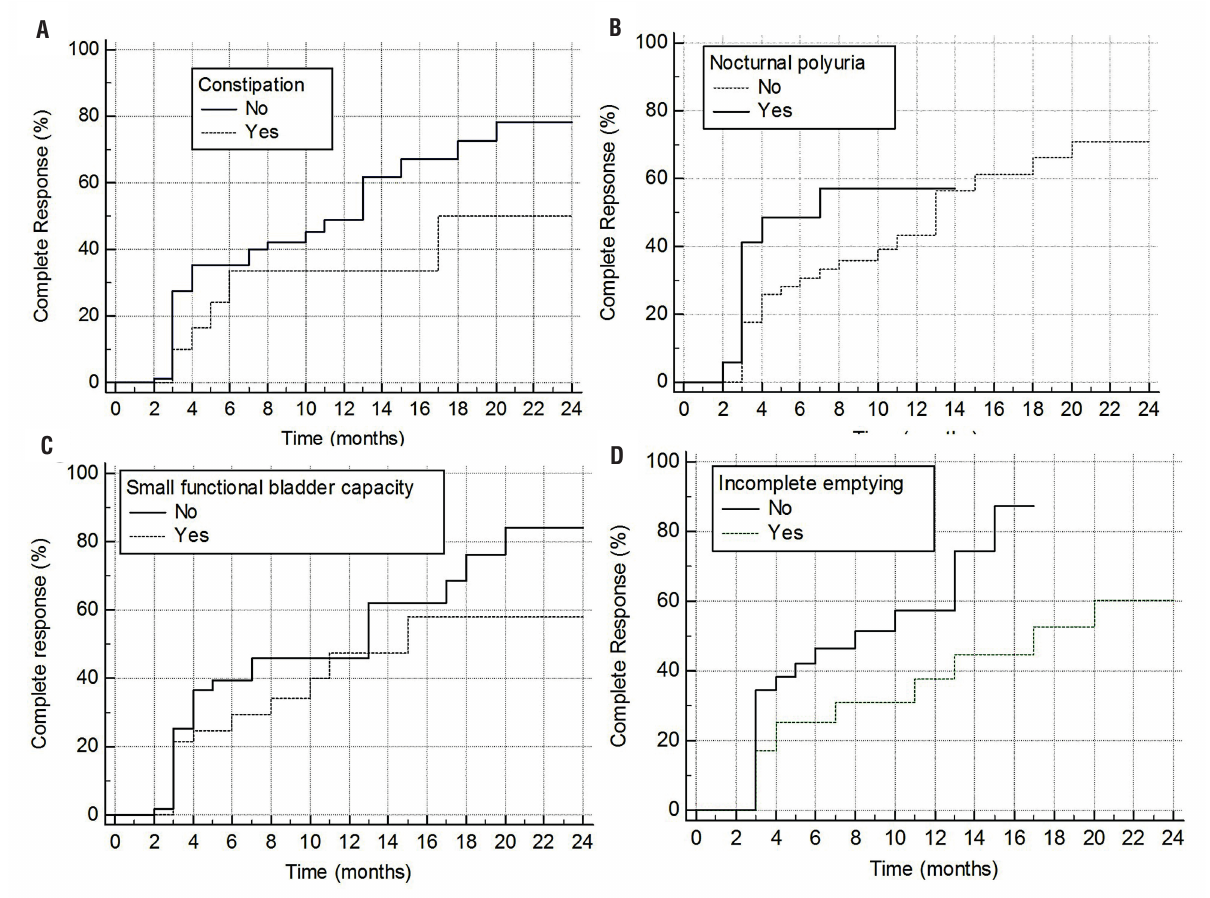
figure 1 - comparison of complete response to desmopressin in enuretic children with and without A) constipation, B) Nocturnal polyuria, c) Small functional bladder capacity, D) Incomplete bladder